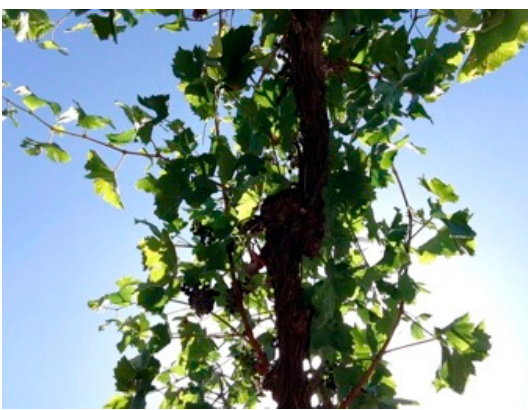
Figure 1. Example of an upward looking grapevine canopy image suitable for analysis using VitiCanopy. The image was obtained using the front camera of an iPad4, at a distance of 80 cm between the vine’s cordon and the device.